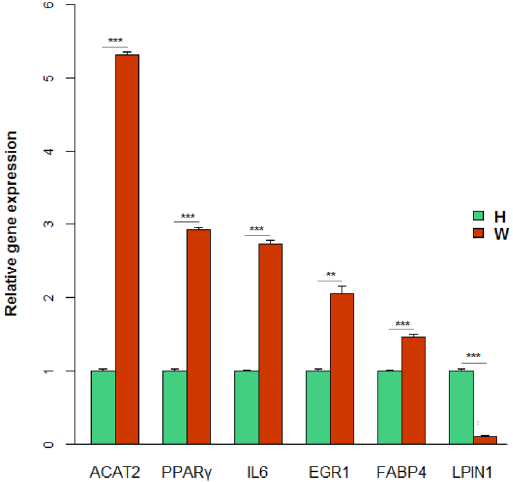
Figure 5. QRT-PCR validation of the differentially expressed genes. The differential expression of genes in subcutaneous fat between Wagyu and Holstein cattle was validated by quantitative real-time PCR. * P < 0.05; ** P < 0.01; *** P <